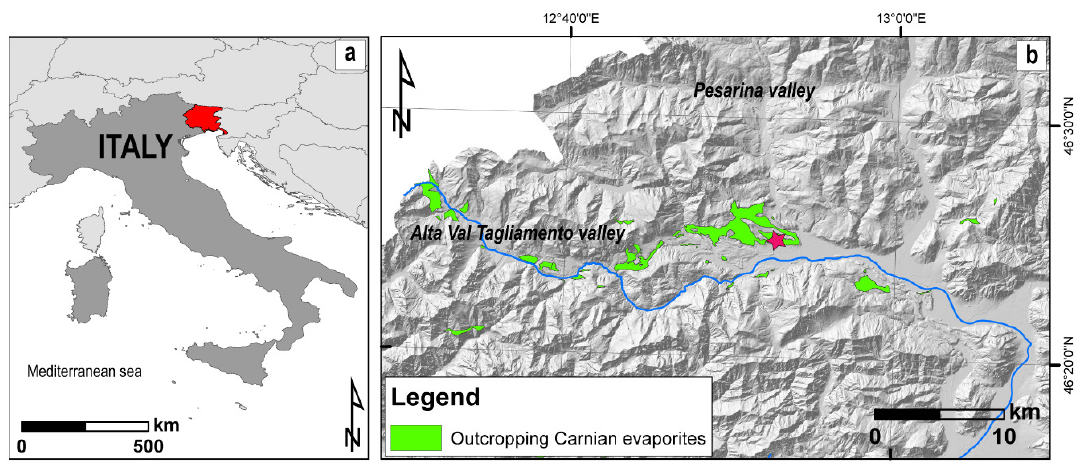
Figure 1. ( a ) Study area location. In red, the Friuli Venezia Giulia region (FVG); ( b ) focus on the Carnian evaporite outcrops (in green) at the NW side of the FVG, mainly within the Alta Val Tagliamento valley. In blue, the Tagliamento River. The red star is placed on Quinis hamlet.